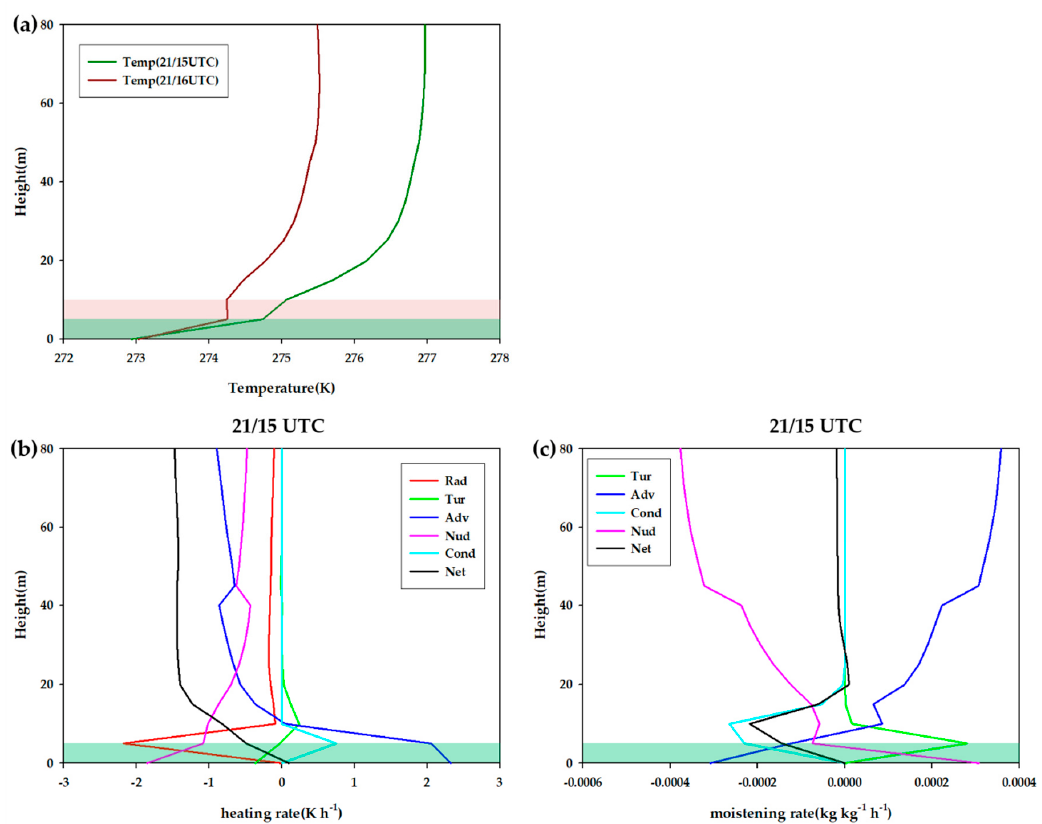
Figure 7. ( a ) Vertical profiles of temperature at earlier times (15 UTC and 16 UTC) of fog development components of ( b ) heating rates and ( c ) moistening rates. The shading indicates the fog layer at 15 UTC (green) and 16 UTC